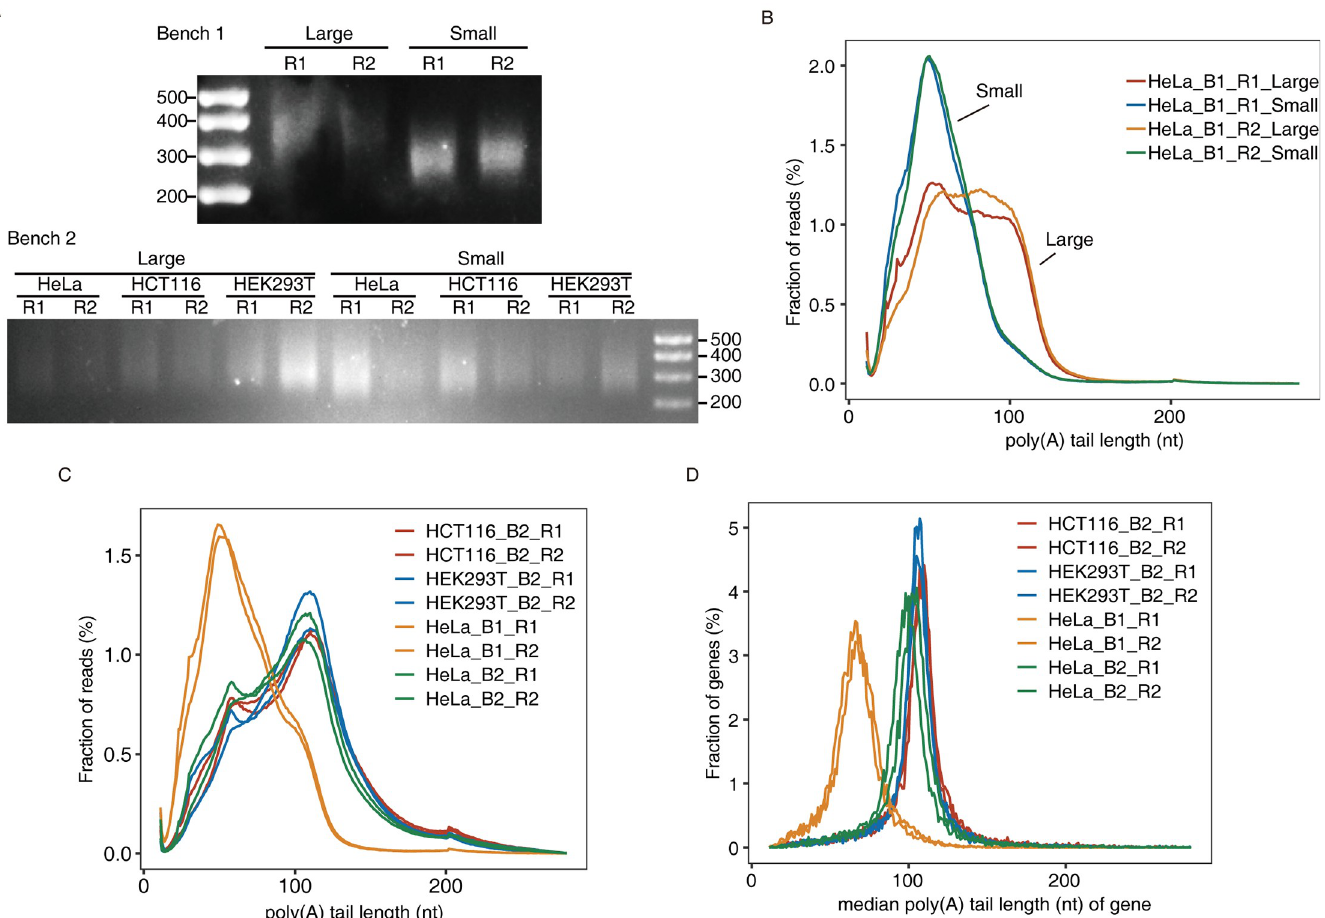
Fig 4. Increase of the detected poly(A) tail lengths by sequencing the larger size of cDNA library and by reducing the size of RNA fragments. A. Electrophoresis gel images of selected cDNA libraries for Poly(A)-seq in two benches of experiments. In experiment 1, after size selection, we separated two different selection products on an agarose gel. “Large” and “Small” were significantly different in sizes, indicating the inserted RNA fragments were not homogenized. In experiment 2, no much difference between these two selections was observed, indicating the inserted RNA fragments were homogenized and smaller. B. Distribution of poly(A) tail length in poly(A)-containing reads in Large and Small cDNA libraries in the experiment 1. C. Poly(A) tail length distribution in reads across all samples. D. Distribution of median poly(A) tail lengths in all genes across all samples.